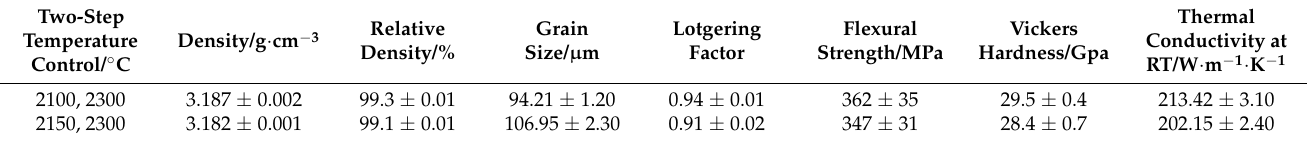
Figure 9. The morphology of dense SiC ceramics induced by nano-array seeds via HTPVT: ( a , b ) the top and side view of samples grown at 2100 ◦ C for 10 min and 2300 ◦ C for 4 h; ( c , d ) the top and side view of samples grown at 2150 ◦ C for 10 min and 2300 ◦ C for 4 h. Table 2. Performance of the SiC